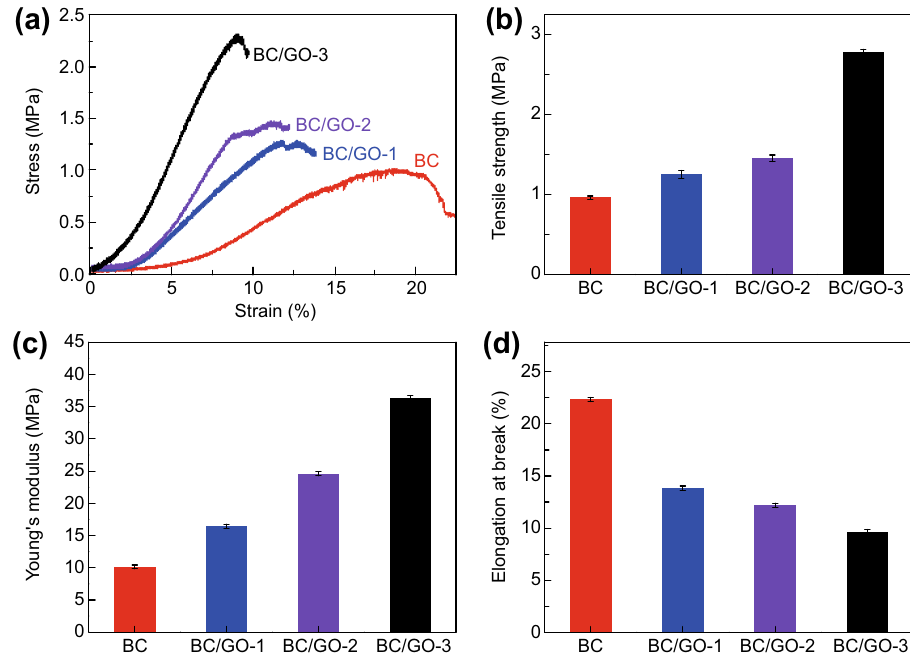
Fig. 6 Typical a stress–strain, b tensile strength, c tensile modulus, and d strain at break of BC and BC/GO